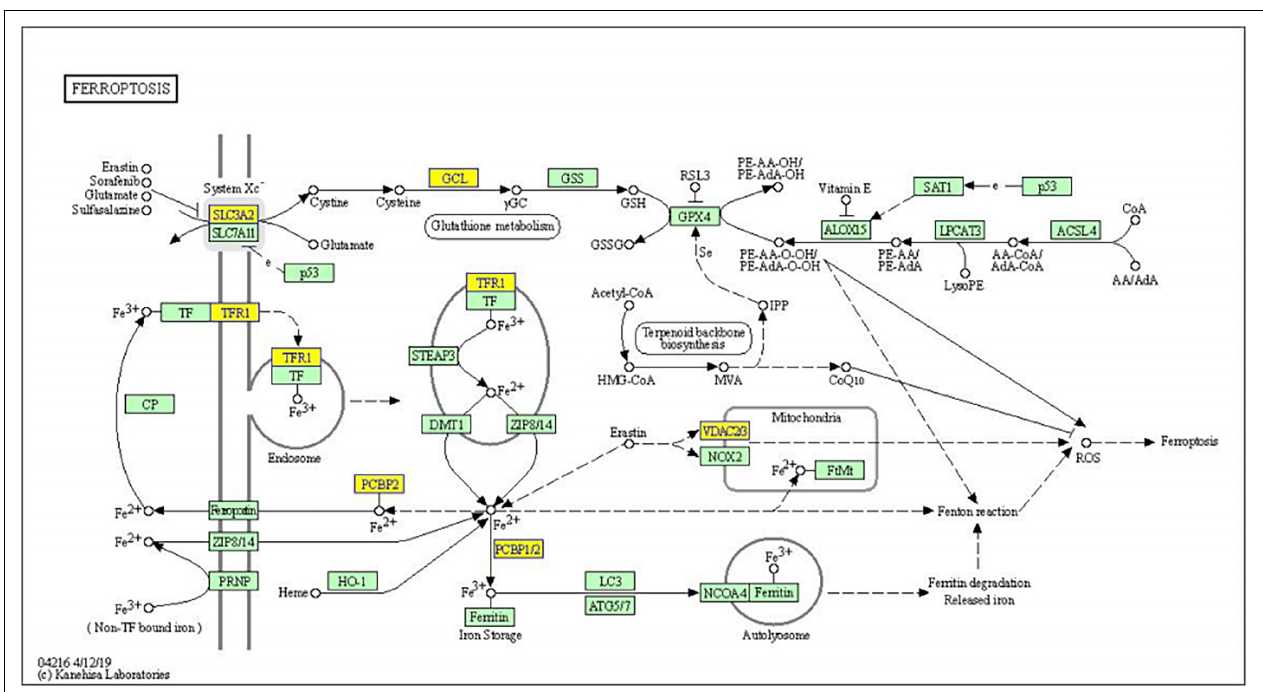
FIGURE 5 | KEGG pathway diagram of ferroptosis involved in differentially expressed genes. Yellow nodes are associated with down-regulated genes, and green nodes have no